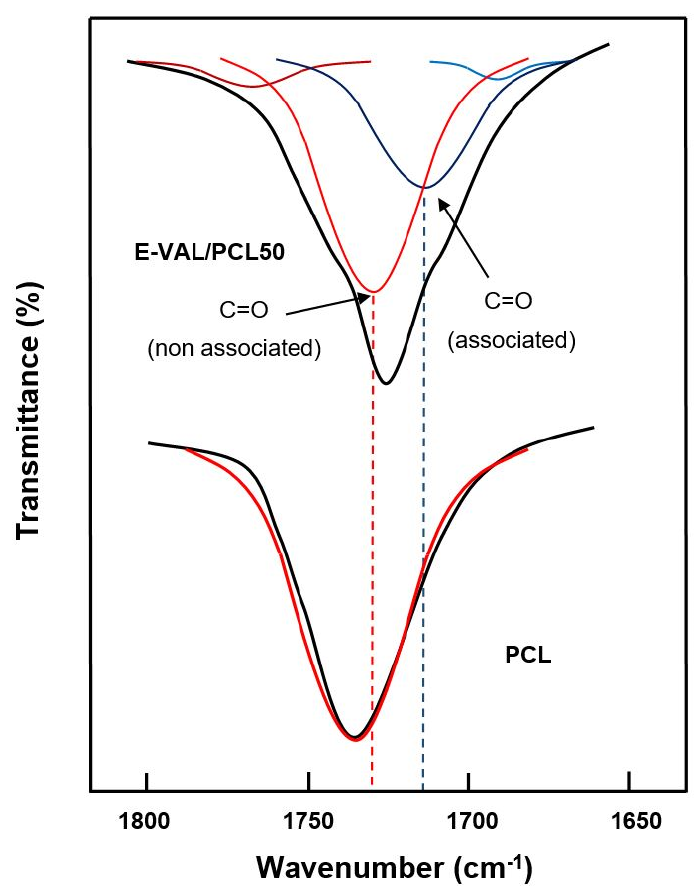
Figure 3. Deconvolution of the absorption band between 1700 and 1800 cm − 1 in free and associated carbonyl peaks of pure E-VAL and E-VAL/PCL50 blend. Table 1. Fractions of associated and free carbonyl bands in 1700–1800 cm − 1 in the E-VAL/PCL blends.